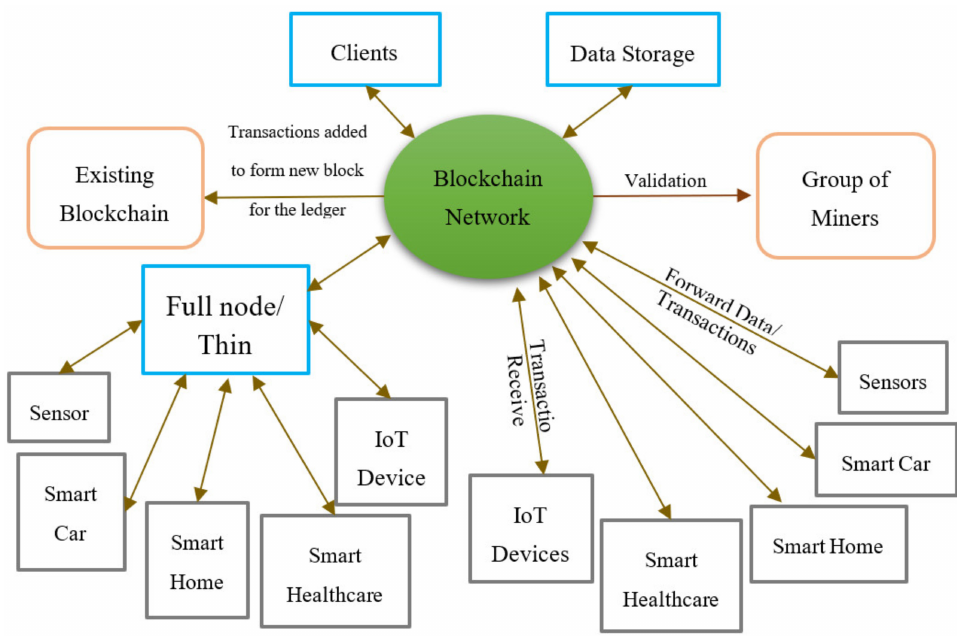
Figure 3. Proposed architecture for an IoT blockchain